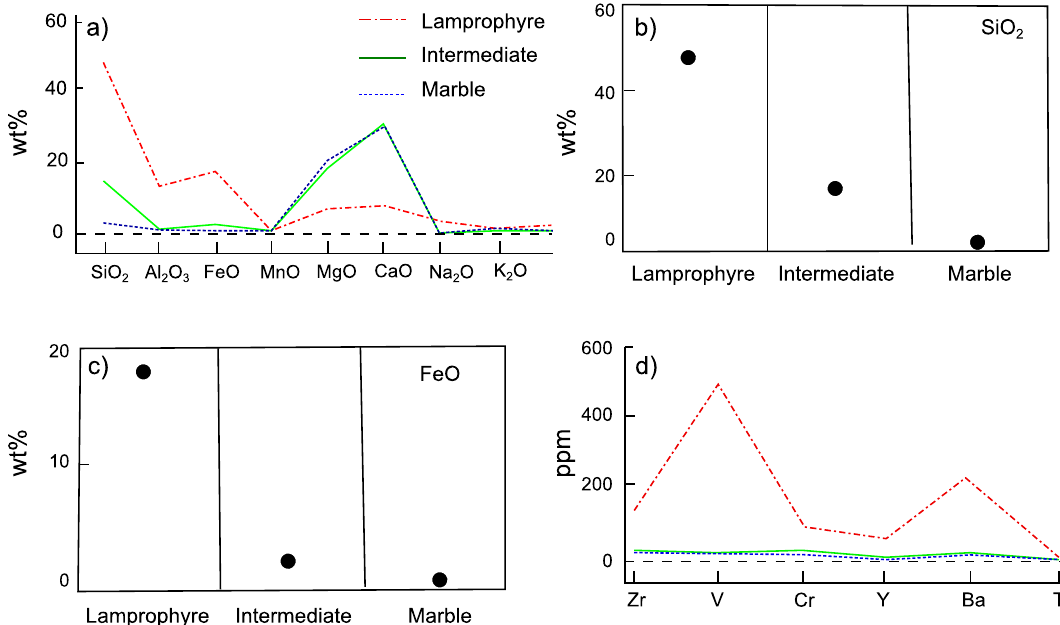
Figure 7. Geochemical enrichment of major elements as well as moderately enriched elements during metasomatism. Compositional diagrams showing the SiO 2 and FeO enrichment (wt %) in the metasomatized marble ( a ), Major element variations (wt %) ( b ), SiO 2 variation (wt %) ( c ), FeO variation (wt %), and ( d ), moderately enriched elements variation from the representative samples (ppm).